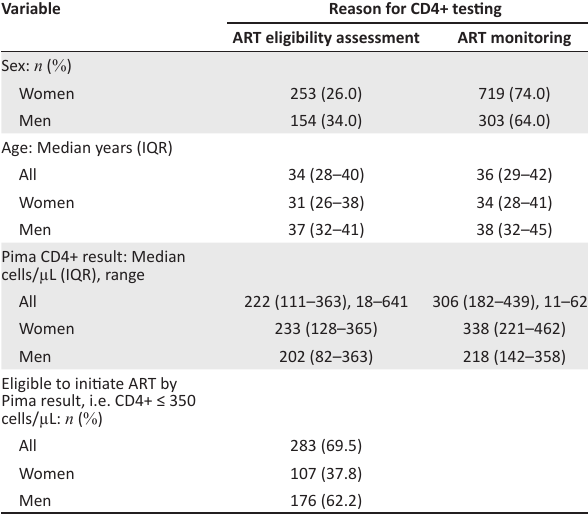
TABLE 2: Comparison of outcomes for point-of-care Pima CD4+ testing performed by nurses or by lay health workers, Namibia, July–August 2011. Variable